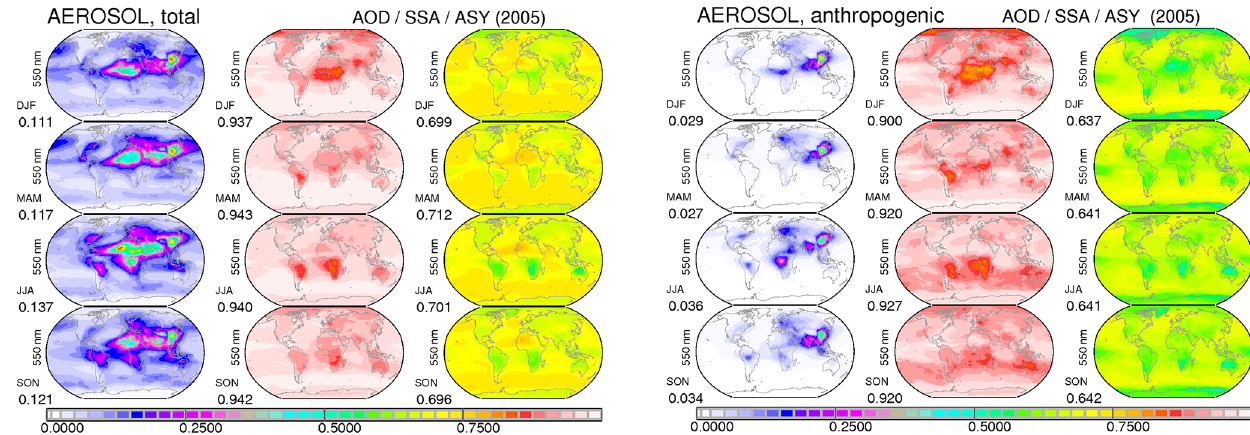
Figure 2. Seasonal maps of MACv2 associated present-day midvisible (550nm) radiative (or single scattering) properties (AOD, SSA, ASY) for total aerosol (left frame) and for anthropogenic aerosol (right frame). Global averages for each season are indicated below the labels. Table 1. Global annual averages of radiative properties for present-day (tropospheric) MACv2 aerosol. AOD SSA ASY λ (µm) Total Coarse Fine Anthropogenic* Total Coarse Fine Total Coarse Fine 0.45 0.144 0.058 0.087 0.043 0.55 1.0 0.081 0.062